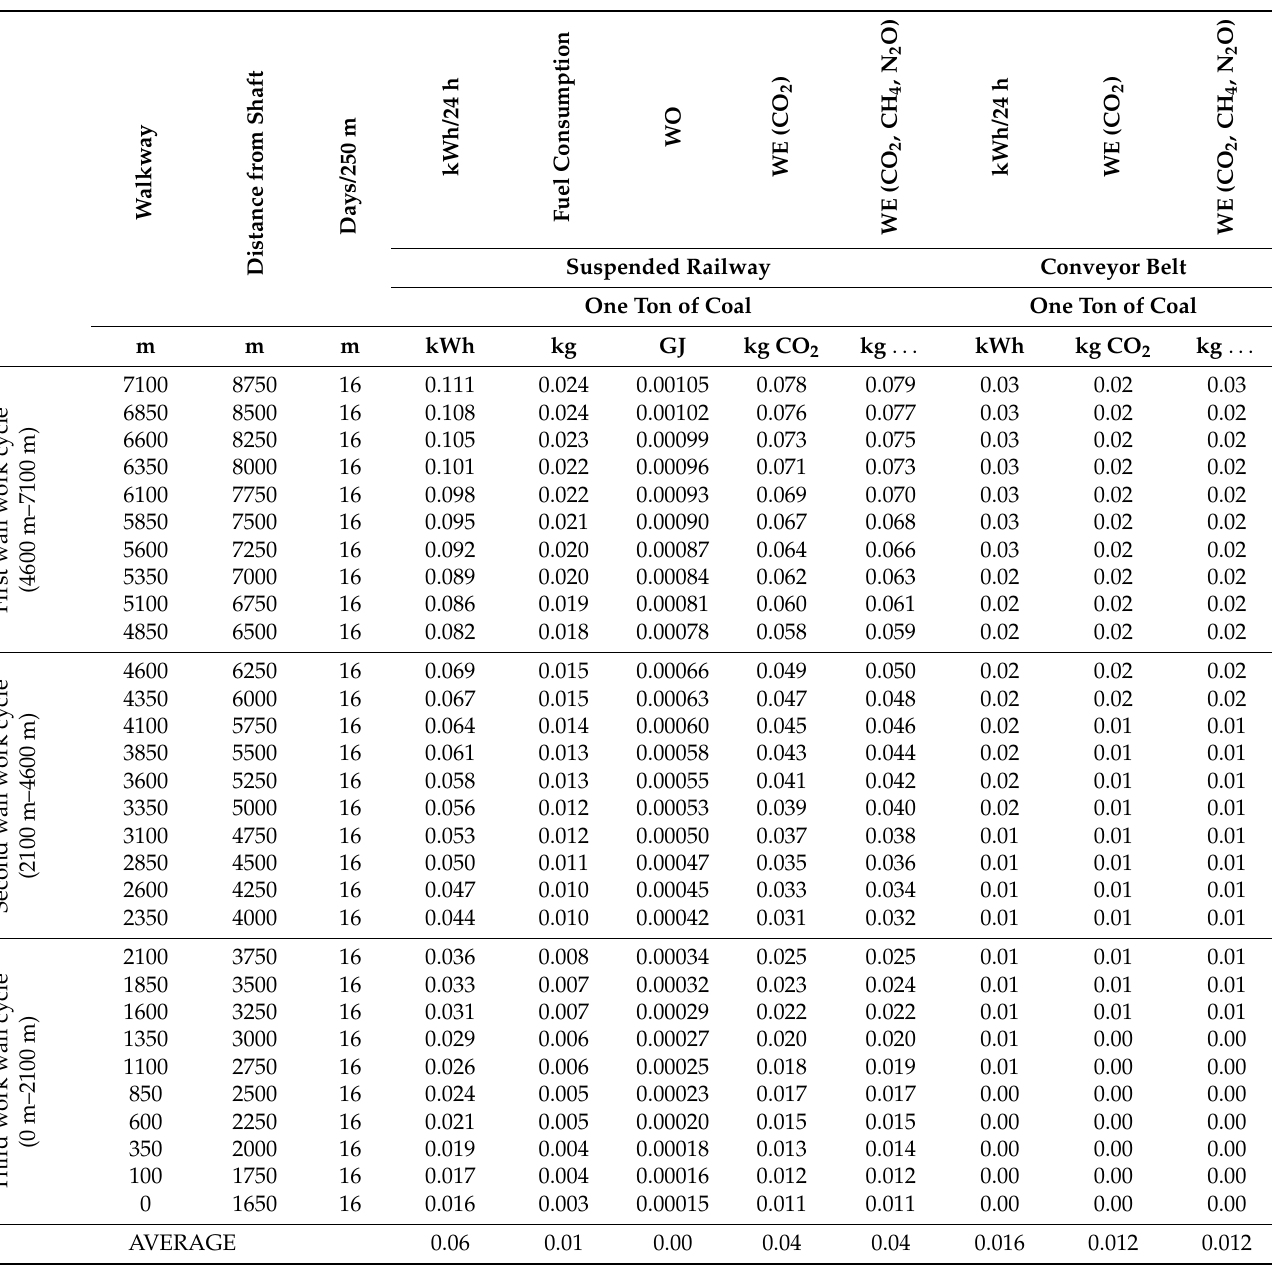
Table 7. Results of GHG energy intensity and emissivity calculations for one ton of extracted